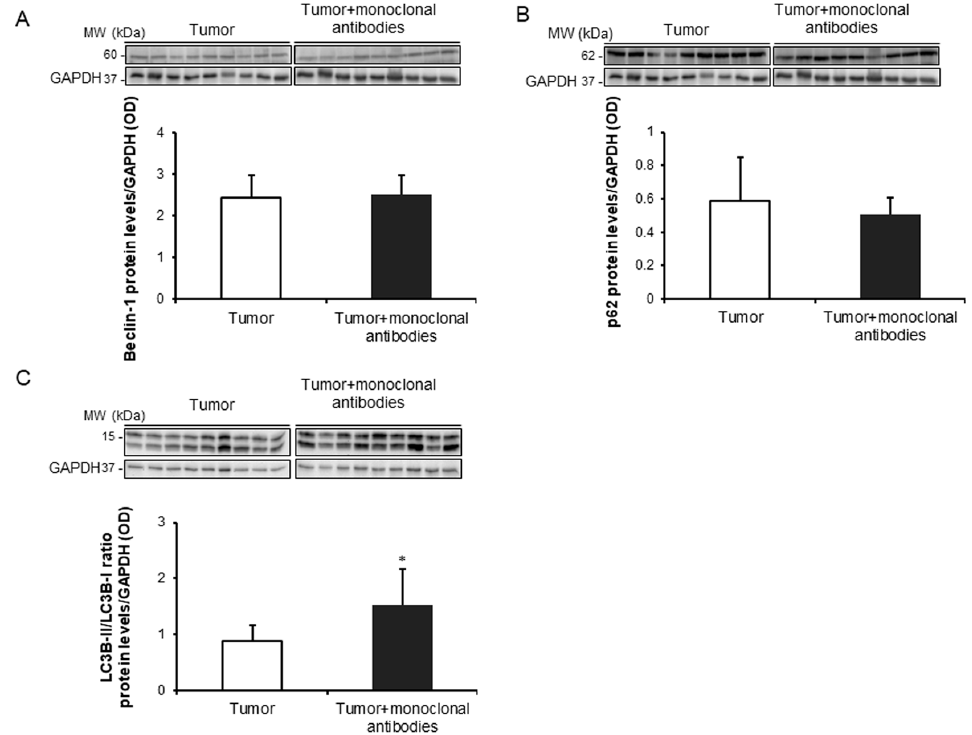
Figure 7. ( A ) Representative immunoblots and mean values and standard deviation of Beclin-1 protein levels/GAPDH in subcutaneous tumors of LC mice as measured by optical densities. ( B ) Representative immunoblots and mean values and standard deviation of p62 protein levels/GAPDH in subcutaneous tumors of LC mice as measured by optical densities. ( C ) Representative immunoblots and mean values and standard deviation of total LC3-II/LC3-I protein/GAPDH in subcutaneous tumors of LC mice as measured by optical densities. Representative GAPDH is shown as the loading control. Statistical significance is represented as follows: *: p ≤ 0.05 between non-treated controls ( N = 9) in white bars and treated lung cancer ( N = 9) mice in black bars. Definition of abbreviations: p62, nucleoporin p62; LC3, microtube-associated protein 1 light chain 3; GAPDH, glyceraldehyde-3-phospate dehydrogenase; OD, optical